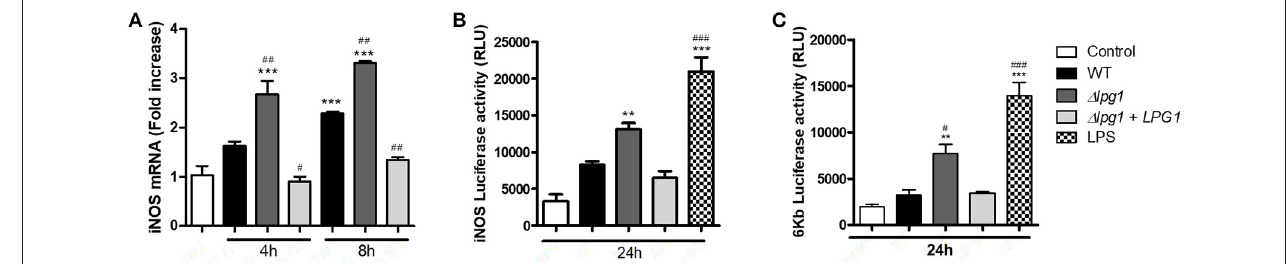
FIGURE 5 | L. infantum promastigotes evade NF- κ B-dependent iNOS in an LPG-dependent manner in RAW 264.7 cells. RAW 264.7 cells were infected with either WT, 1 lpg1 or 1 lpg1 + LPG1 promastigotes. After 4 or 8h of infection, iNOS expression was determined by qPCR (A) . RAW 264.7 cells were transfected with either the iNOS promoter reporter construct pTK-3XNS, or the NF- κ B consensus luciferase reporter construct (p6 κ B-Luc) prior to infection with either L. infantum WT, 1 lpg1 or 1 lpg1 + LPG1 , or stimulation with LPS. At 24h post-infection, activity of the iNOS promoter (B) and the NF- κ B reporter (C) was measured by quantification of luciferase activity (B) . Bars represent means ± SE of three representative experiments performed in triplicate for murine cells. *** p < 0.0001; ** p < 0.001 compared to control. ### p < 0.0001, ## p < 0.001 and # p < 0.05 compared to WT. P < 0.0001 compared with control group Student Newman-Keuls